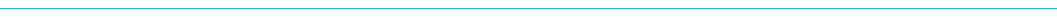
Figure 4: Age standardised mortality rates (ASMR) (European standard [32]) per 100 000 person-years for ischaemic heart disease (IHD) by sex for the population of 17 high-income countries, age 0–74 years, time periods 1997/1998 and 2006/2007.All results in this figure, other than those for Switzerland, are based on figures published by Nolte and McKee (2011) [18]. Unlike the present study, Nolte and McKee did not treat amenable causes and ischaemic heart disease (IHD) separately. Instead, 50% of deaths caused by IHD were classified as amenable. Based on the published figures, the rates of amenable conditions and IHD were recalculated to enable an isolated consideration of amenable and deaths caused by IHD. For countries with populations <10 million, rates are based on combined years (Austria, Denmark, Finland, Ireland, New Zealand, Norway, Sweden and Switzerland). For simplicity, this is referred to as combined years, with 1997/1998 as the starting point and 2006/2007 as the end point of the period under review. The sequence reflects the order based on the results of